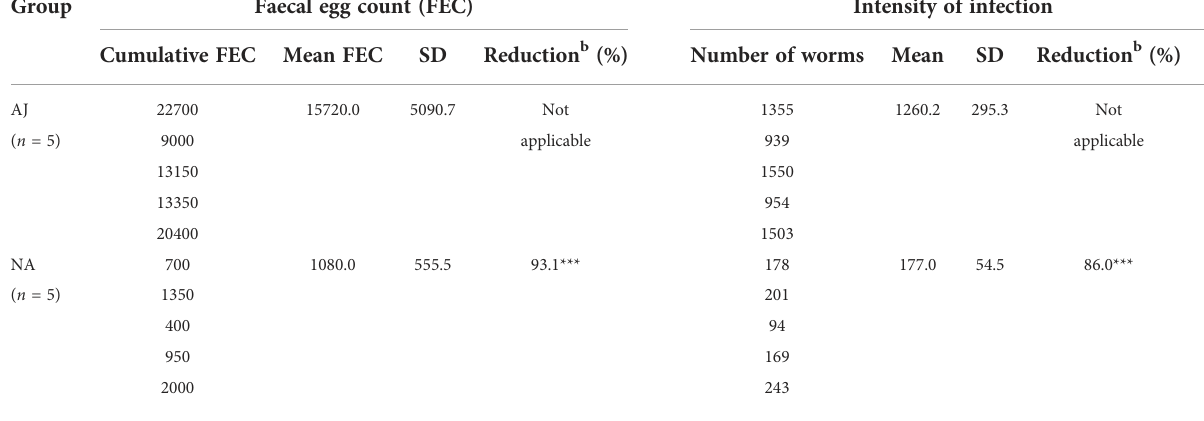
TABLE 1 Results from the immunisation trial in goats. Four groups of fi ve goats each were injected with adjuvant alone (AJ), native H11 (NA), denatured H11 (DA) or periodate-treated H11 (PI), respectively and then challenged with 7000 third-stage larvae (L3s) of H. contortus (day 42, cf. Figure 4A ). Faecal samples were taken from individual goats at eight time points (cf. Figure 4A ), and the number of H. contortus eggs per gram was counted (faecal eggcount, FEC). Cumulative FEC of individual goats and mean cumulative FEC (with standard deviations, SD) were calculated for each group. At the end of the experiment (day 80), the numbers of worms in the stomachs (abomasa) were counted, and the reduction in the intensity of infection was calculated for each group. Group Faecal egg count